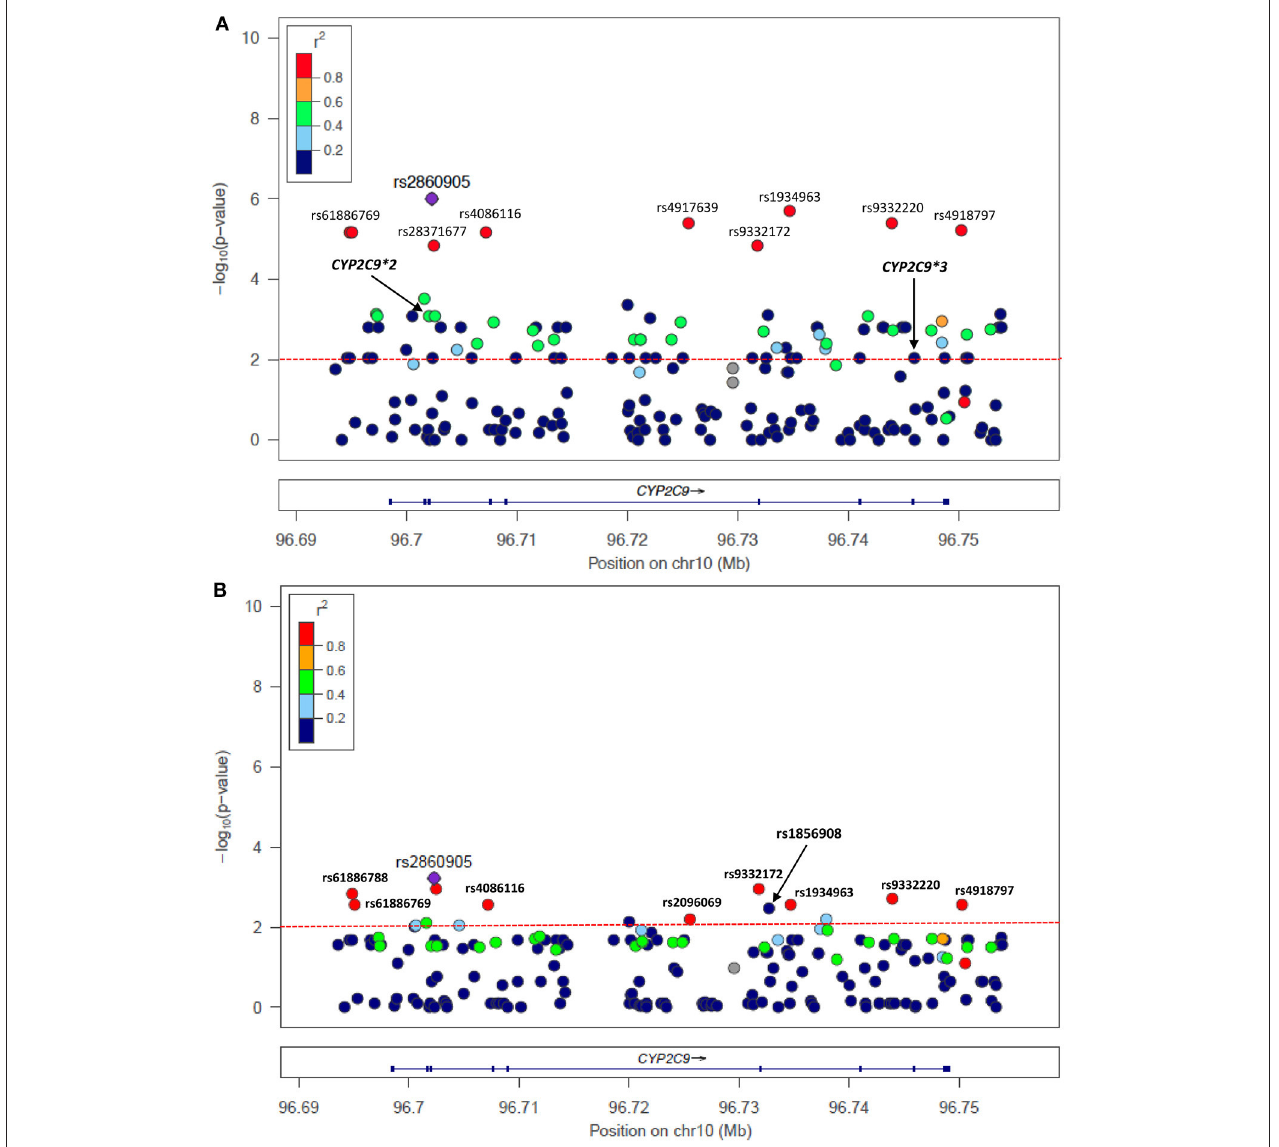
FIGURE 3 | Single nucleotide variants (SNVs) at CYP2C9 associated with warfarin (A) sensitivity ( < 4 mg/day) and (B) resistance ( > 6 mg/day) identified with NGS. P -values correspond to case-control association test performed in Puerto Ricans of the present study but colored codes represent correlation of SNVs with rs2860905 among Hispanics from 1,000 Genomes (Puerto Ricans, Colombians, Mexican Americans and